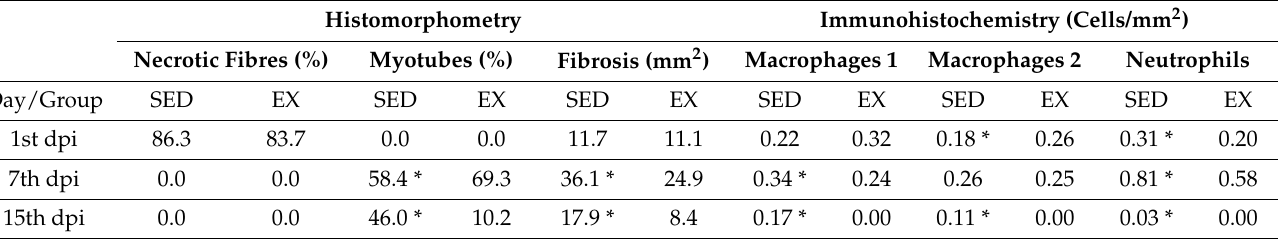
Table 1. Histomorphometric data and inflammatory-cell presence in the different